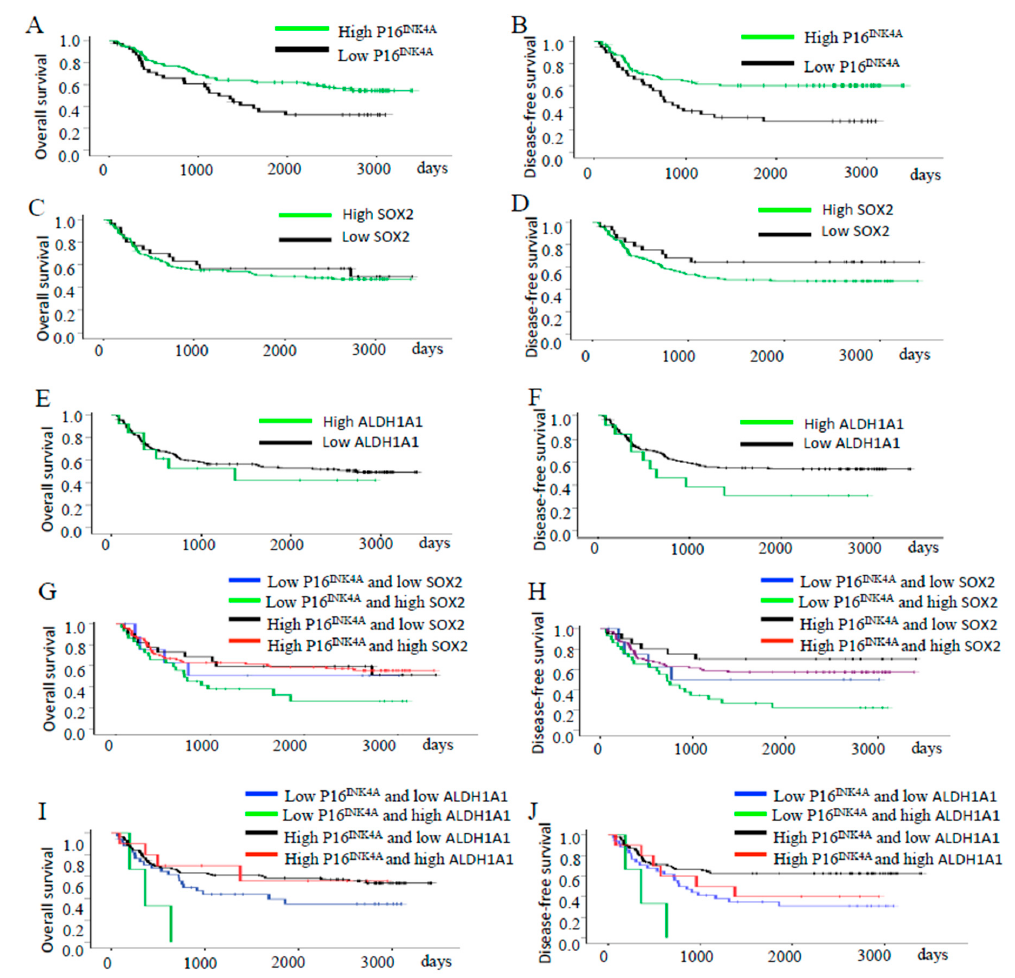
Figure 3. Survival and recurrence outcomes of patients with different expressions of P16 INK4A , SOX2, and ALDH1A1 in tumors. ( A , B ) Cervical cancer patients with high P16 INK4A expression had a better five-year OS rate ( p = 0.016) and better five-year DFS rate ( p = 0.02) than those with lower expression. ( C , D ) Patients with high SOX2 expression had similar five-year OS and DFS than those with low expression ( C , p = 0.598 and D , p = 0.141). ( E , F ) Patients with high ALDH1A1 expression had similar five-year OS and DFS than those with low expression ( E , p = 0.591 and F , p = 0.131). ( G , H ) The patients with low P16 INK4A /high SOX2 expression had similar five-year OS rates ( G , p = 0.118) but worse five-year DFS rates ( H , p = 0.009) than those with high P16 INK4A /lower SOX2 expression. ( I , J ) The patients with low P16 INK4A /high ALDH1A1 expression had worse five-year OS rates ( I , p = 0.030) and worse five-year DFS rates ( J , p = 0.003) than those with high P16 INK4A /lower ALDH1A1